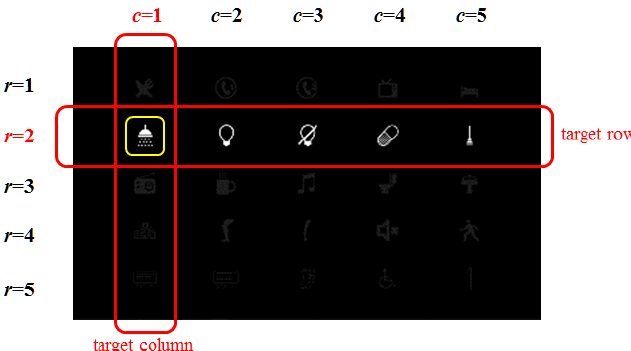
Figure 5. Illustration of the target rows and columns. If the element surrounded by the yellow box is the target element that a user keeps looking at during the data collection, the first column and the second row are defined as the target column and target row, respectively.